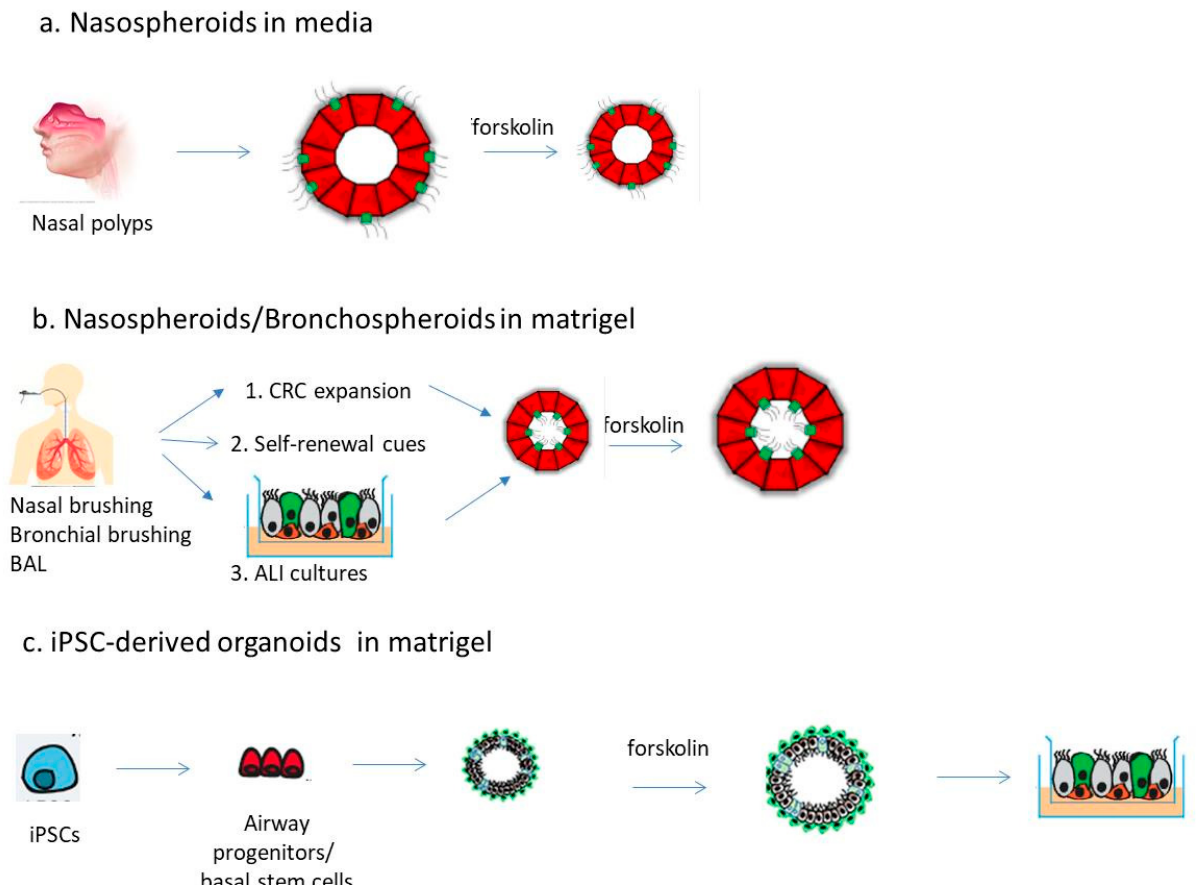
Figure 1. Overview of available strategies to generate airway spheroids/organoids. ( a ) Spheroids can be obtained from nasal polyps upon enzymatic digestion or cells derived from nasal curettage/brushing and cultured in liquid media, not allowing their adherence to the plate (e.g., by gentle shaking). ( b ) Differentiated or stem/progenitor cells obtained from nasal or bronchial brushing as well as from bronchoalveolar lavage (BAL) can be induced to form spheroids in matrigel. Three methods have refined the generation of such spheroids: (1) the conditioned reprogramming culture (CRC); (2) by adding self-renewal cues; (3) first forming 2D ALI cultures and then spheroids from them. ( c ) iPSC-derived lung progenitor cells or basal stem cells are directed to form organoids in matrigel. Organoids can eventually be “split-open” on 96-well plates. Spheroids/organoids can be studied by forskolin-mediated CFTR activation and subsequent fluid transport, with shrinking ( a ) or swelling ( b , c ) depending on epithelial lumen formation.